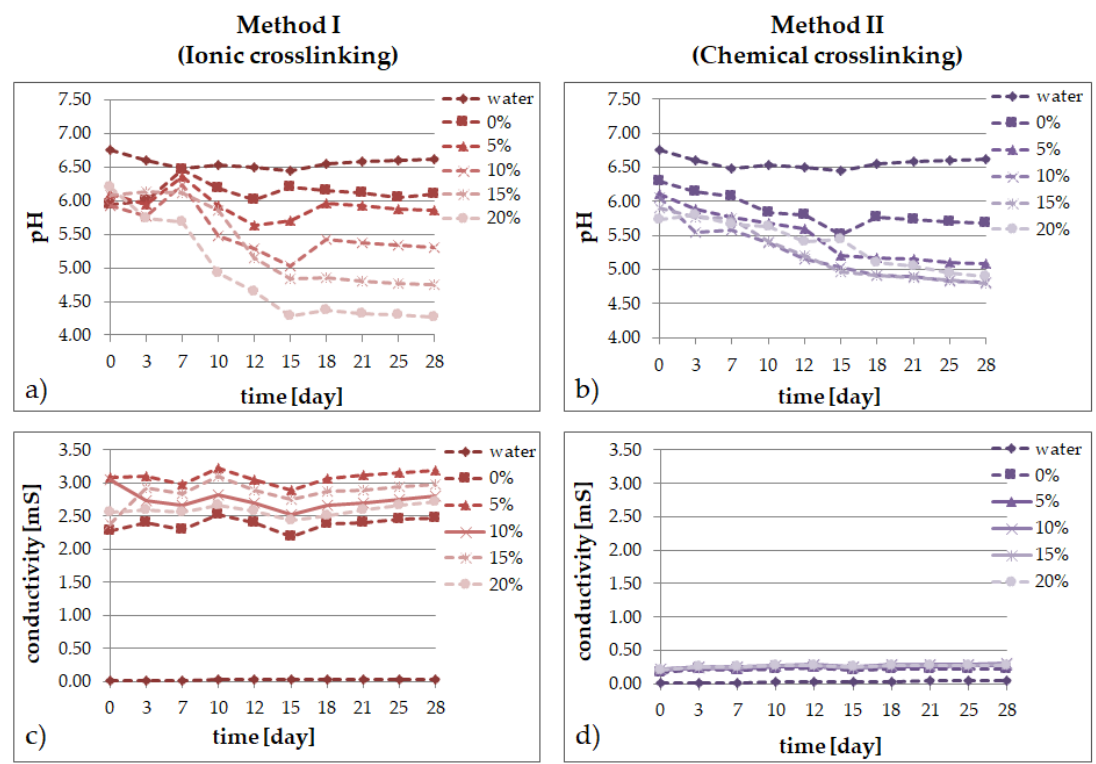
Figure 2. Changes of distilled water during 28 days for SA/PVA/ EP hydrogels prepared using method I (left side) or method II (right side) in pH value ( a , b ) and conductivity ( c , d ).